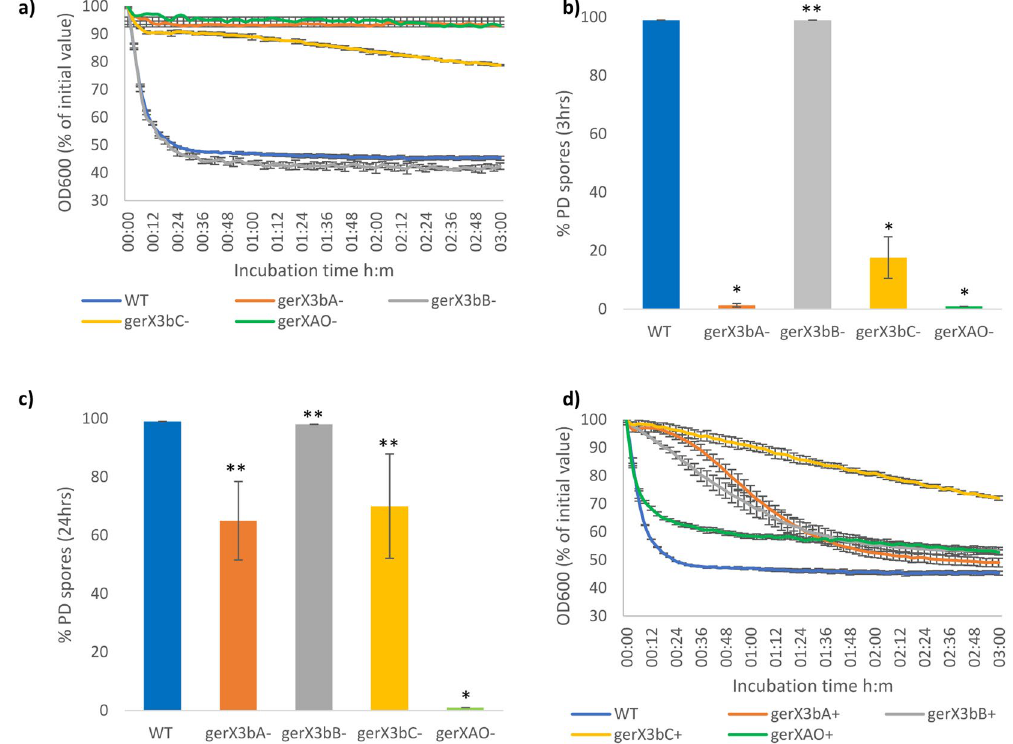
Figure 4. Effect of L-alanine (50 mM) on spore Germination of C . botulinum Eklund 17B gerX3bA − , gerX3bB − , gerX3bC − , gerXAO − and wild type. ( a ) Kinetics of spore germination determined using fall